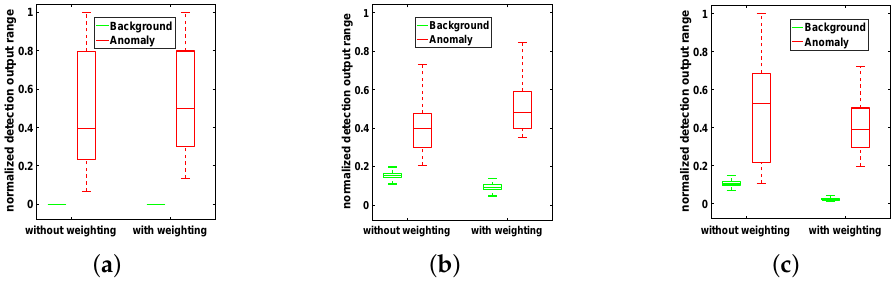
Figure 12. Effect of adaptive weighting on the background-anomaly separation map for each dataset.